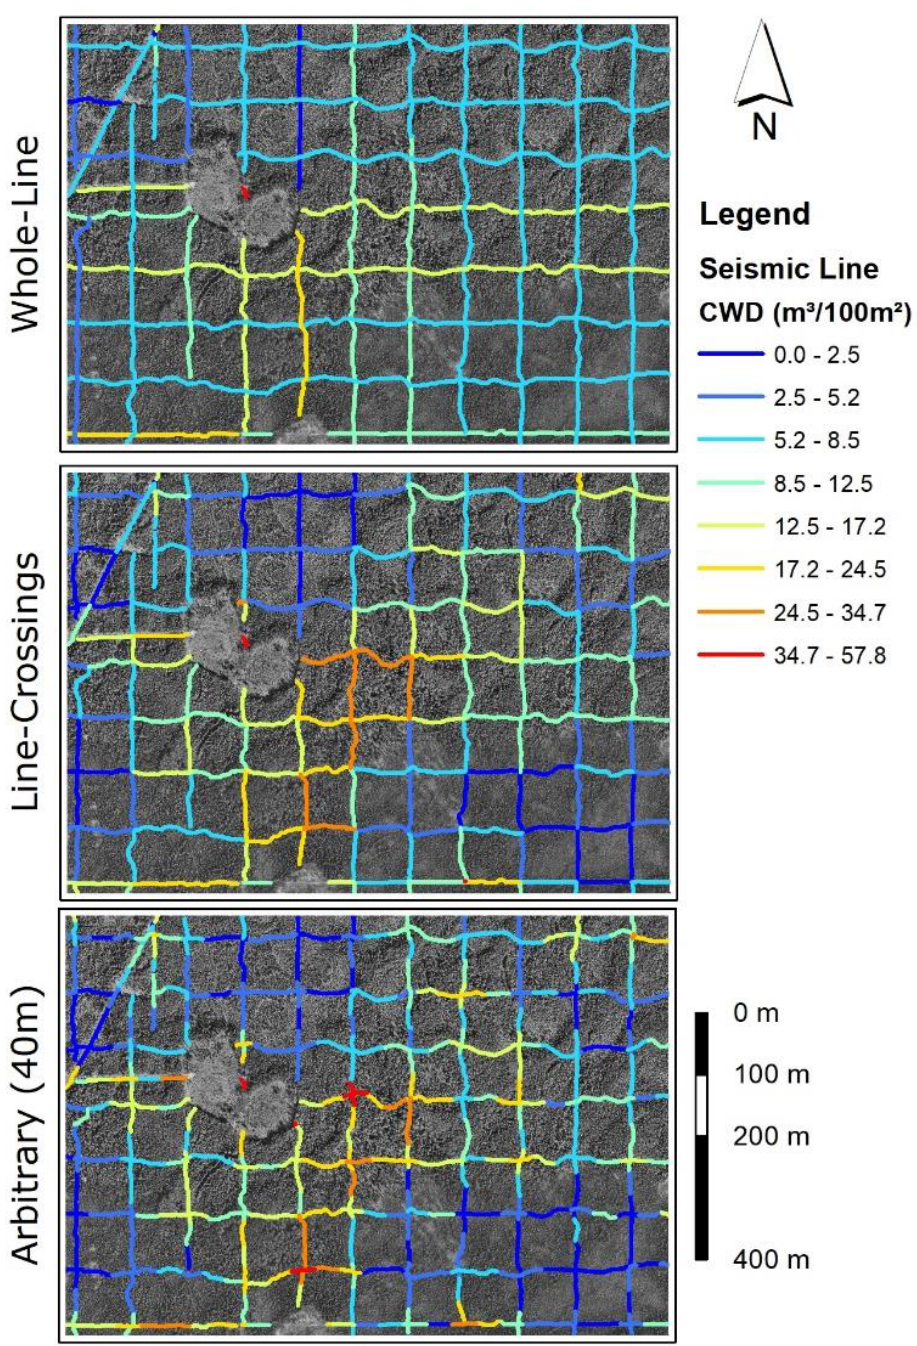
Figure 3. The Forest Line Mapper’s three segmentation options for defining the entities used for summarizing attributes: whole-lines, line-crossings (line intersections), and arbitrary. The whole-line option summarizes attributes across the entire line. The line-crossing option summarizes attributes between intersections. The arbitrary option summarizes attributes along arbitrary (in this case, 40 m) segments. These three example maps show average coarse woody debris (CWD; fallen dead trees) volume on seismic lines and were derived from a CWD raster layer from a separate study (Queiroz et al., 2020).